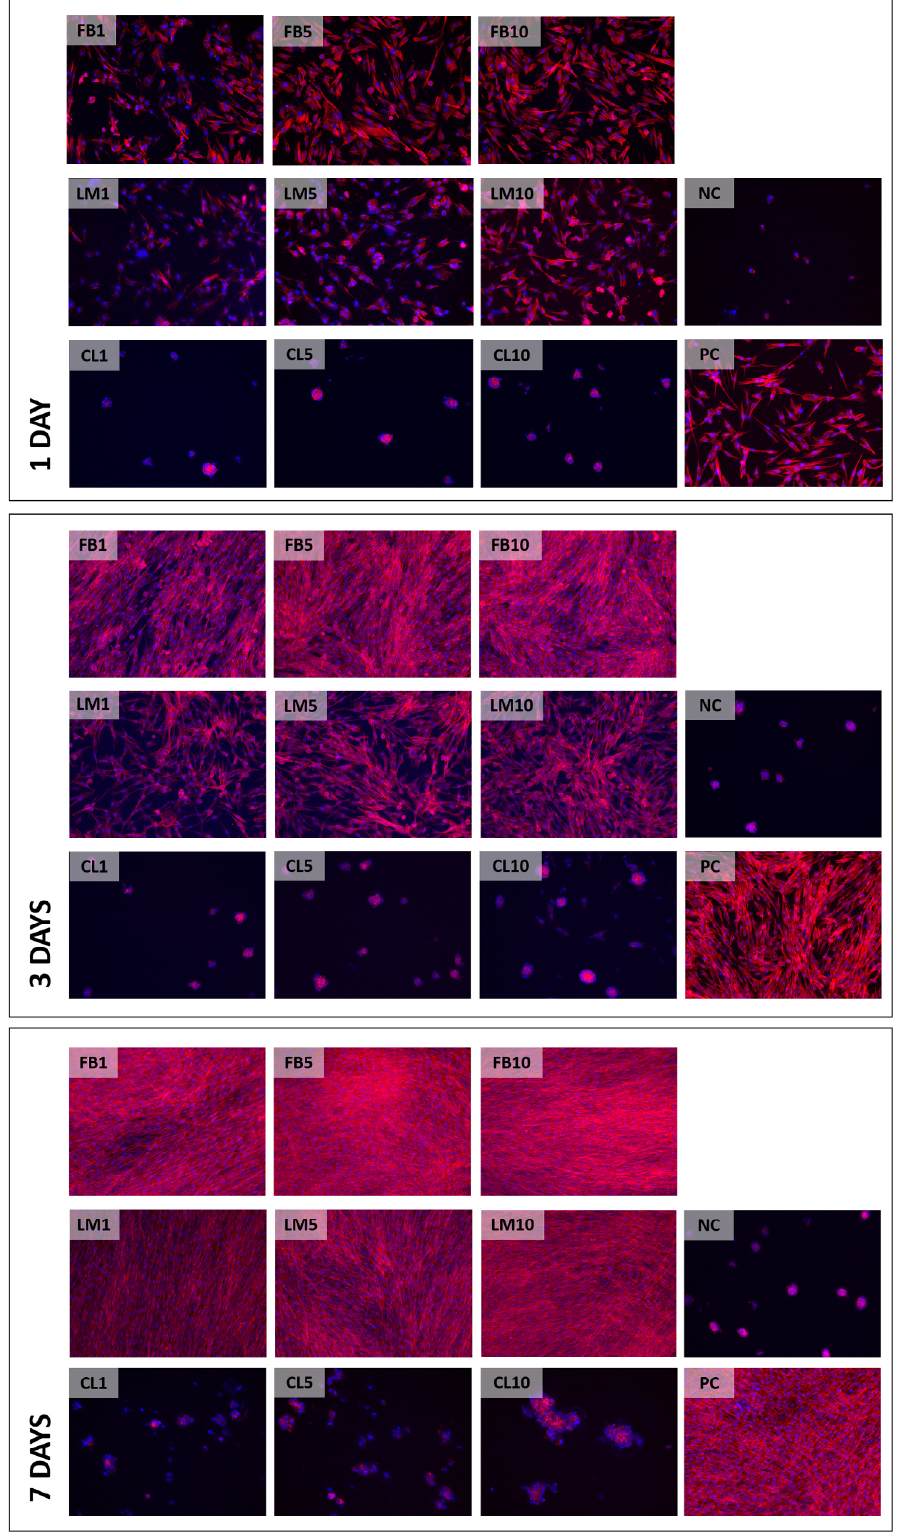
Figure 4- Representative images of F-actin assay (10×). Red fluorescence indicates the actin filaments. Blue fluorescence indicates the cell